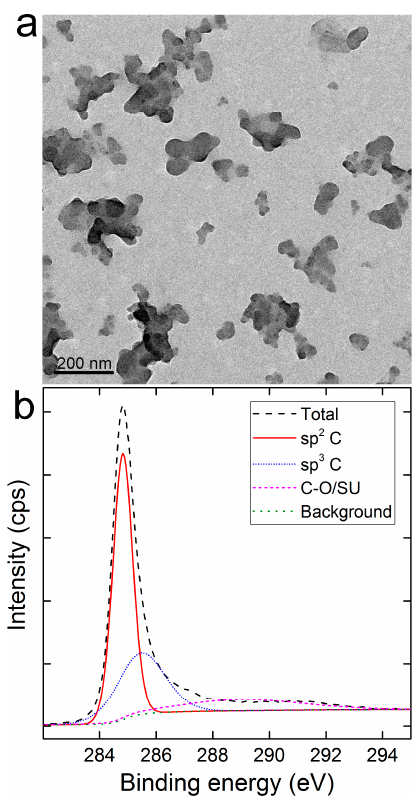
Figure 1. Transmission electron microscopy (TEM) image ( a ) and C1s X-ray photoelectron spectroscopy (XPS) spectrum ( b ) of carbon nanoparticles suspension injection (CNSI).